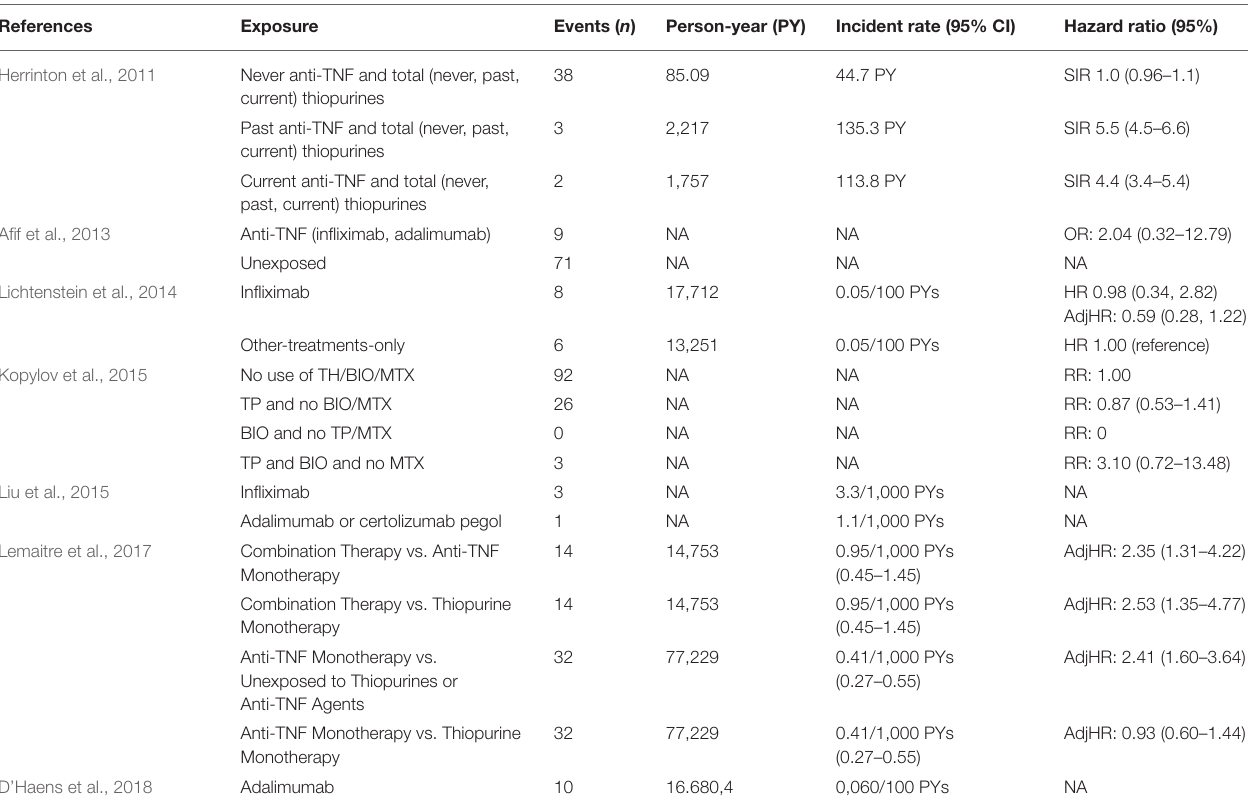
TABLE 2A | Studies with lymphoma as specific